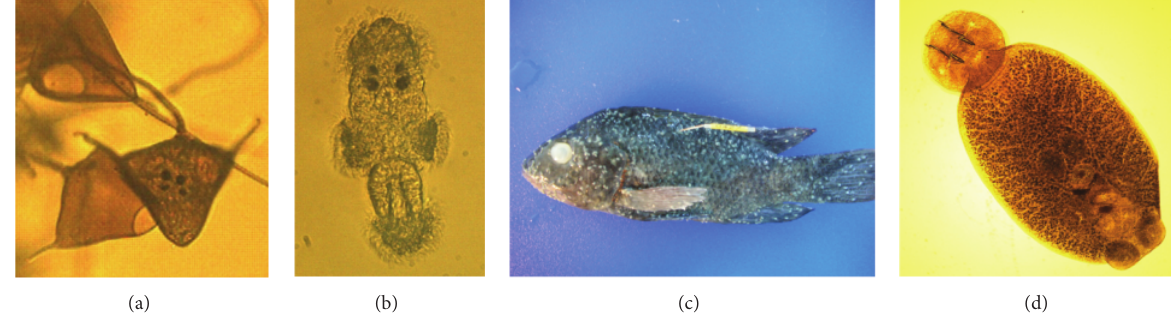
Figure 1: Life cycle of the Hawaiian N. melleni . (a) Recently hatched eggs and single egg with eyespots. (b) Oncomiracidia. (c) Infected tilapia. (d) Adult